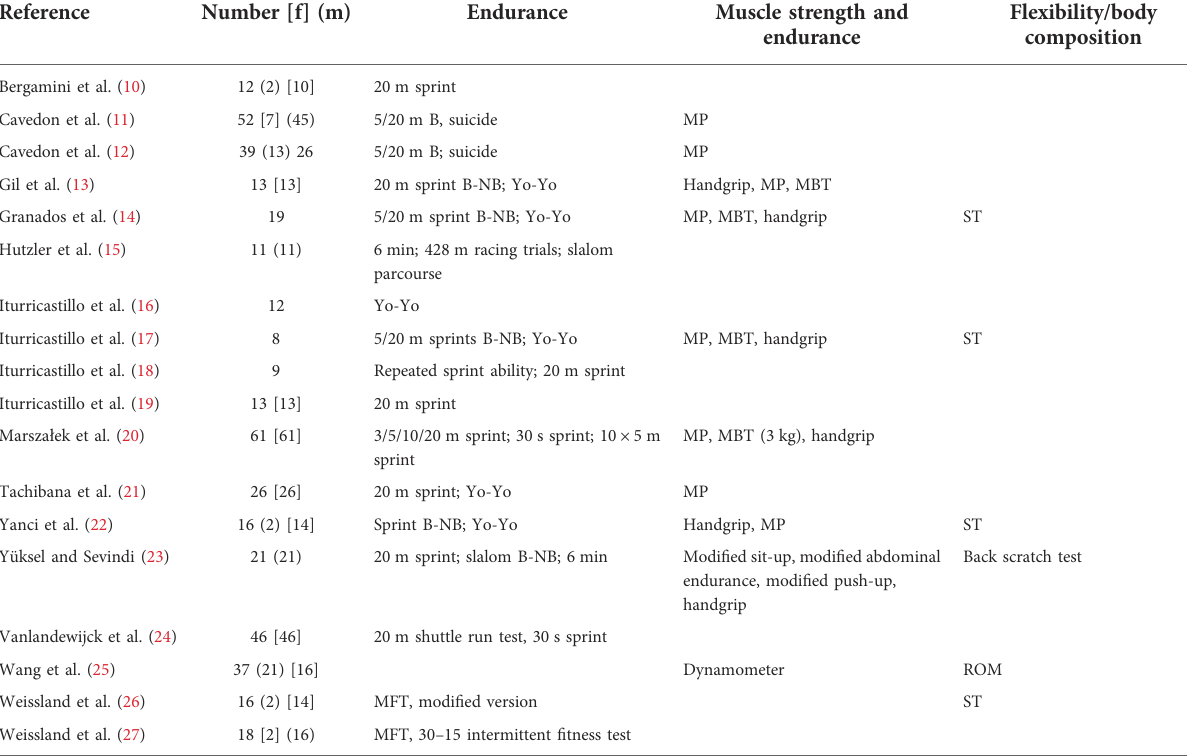
TABLE 1 Information of the included